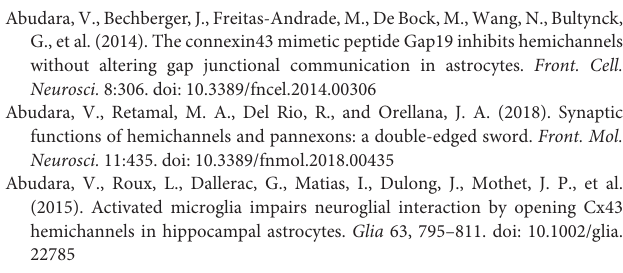
of peak amplitude of spontaneous [Ca 2 + ] i oscillations by hippocampal astrocytes in acute slices from control offspring (white bar) or prenatally LPS-exposed offspring of 4 months old alone (black bars) or in combination with 0.5 µ M TTX and the following pharmacological agents: 100 µ M gap19, 100 µ M Tat-L2,